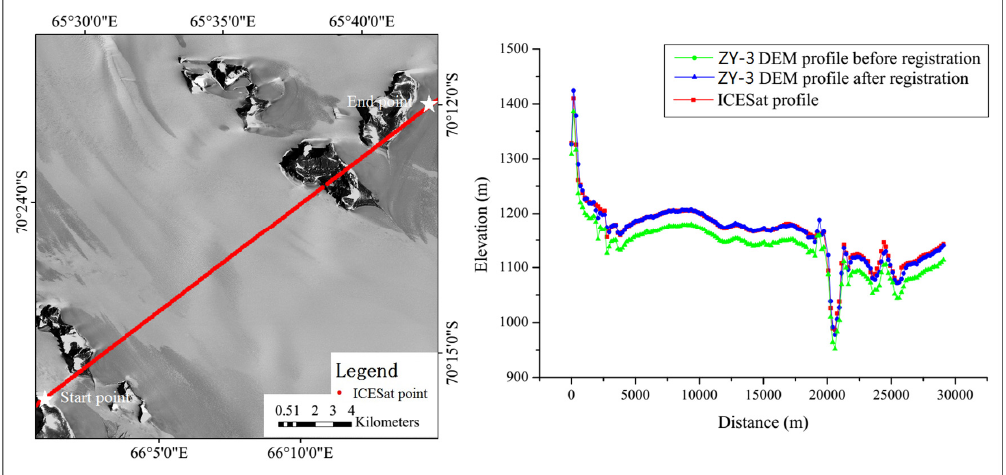
Figure 9. Profile comparison along an ICESat track between the ICESat data and the derived DEMs from the ZY-3 images before and after registration. Table 2. Elevation discrepancies before and after registration (unit: m). Before Registration After Registration ASTER vs.